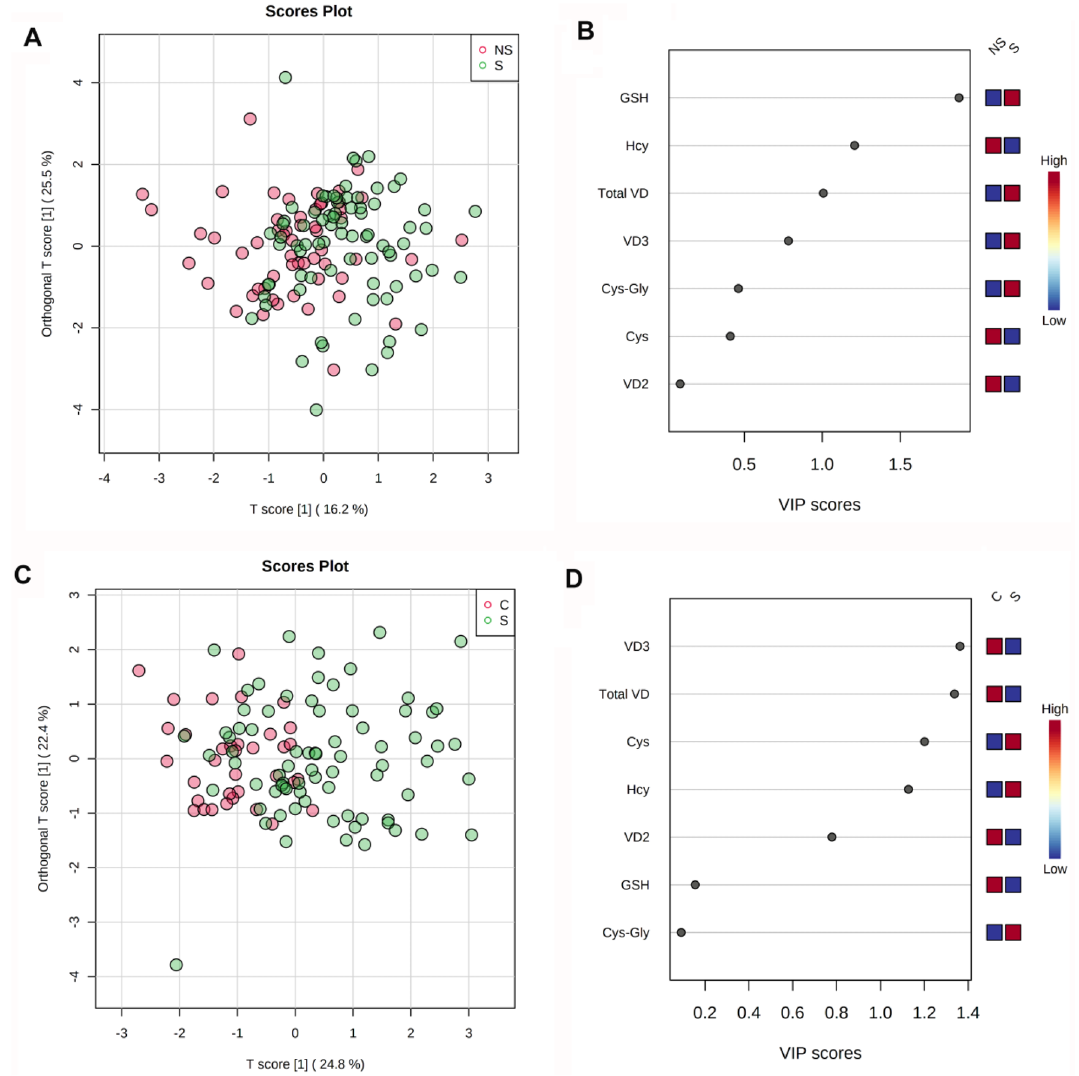
Figure 3. Orthogonal Partial Least Squares (OPLS-DA) analysis of serum vitamin D and thiols in COVID-19 patients. The figure shows the OPLS-DA score plot and Variable Importance in Projection (VIP) score-plot of the OPLS-DA model calculated to discriminate between non-survived (NS) and survived (S) adult patients ( A , B ), and S and children (C) ( C , D ) patients